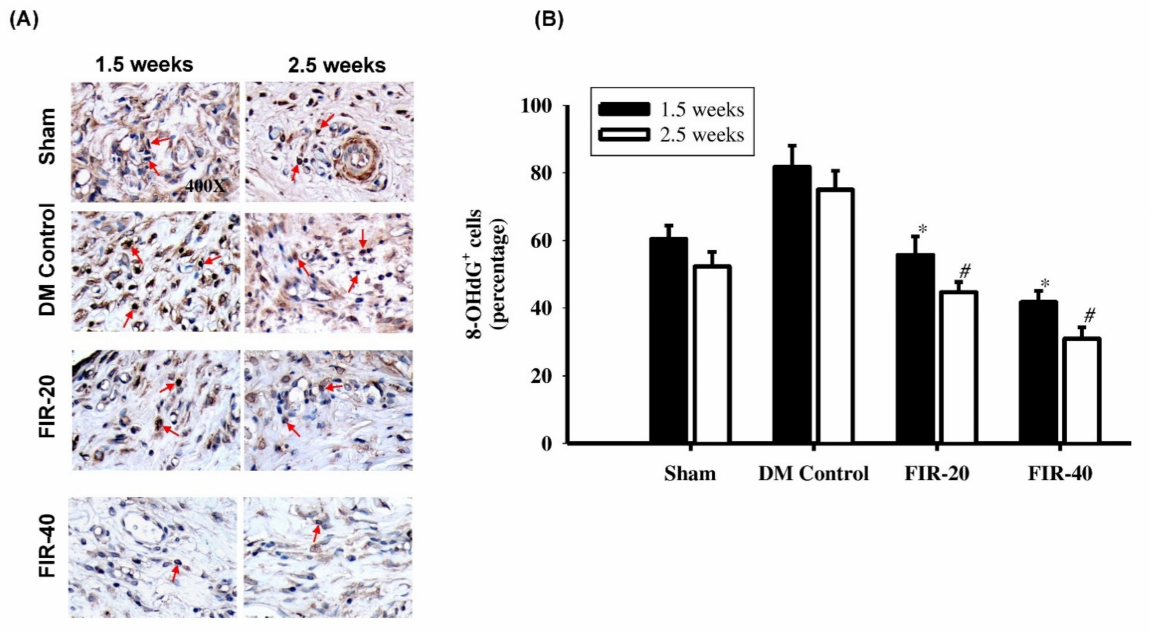
Figure 4. Far-infrared radiation (FIR) treatment for suppression of oxidative stress. ( A ) The oxidative damage indicated by the 8-OHdG level (red arrows) revealed a significant decrease in the diabetic wound healing process in the FIR-treated groups at the early (1.5 weeks) and the late (2.5 weeks) phase post-treatment compared to the DM control group. ( B ) Summary of 8-OHdG level in periwound edges after FIR-treatment. Furthermore, the rats in the FIR-40 group exhibited a marked decrease in 8-OHdG expression compared with the rats in the FIR-20 group. * p < 0.05 (at 1.5 weeks); # p < 0.05 (at 2.5 weeks). Magnification, 400 × .